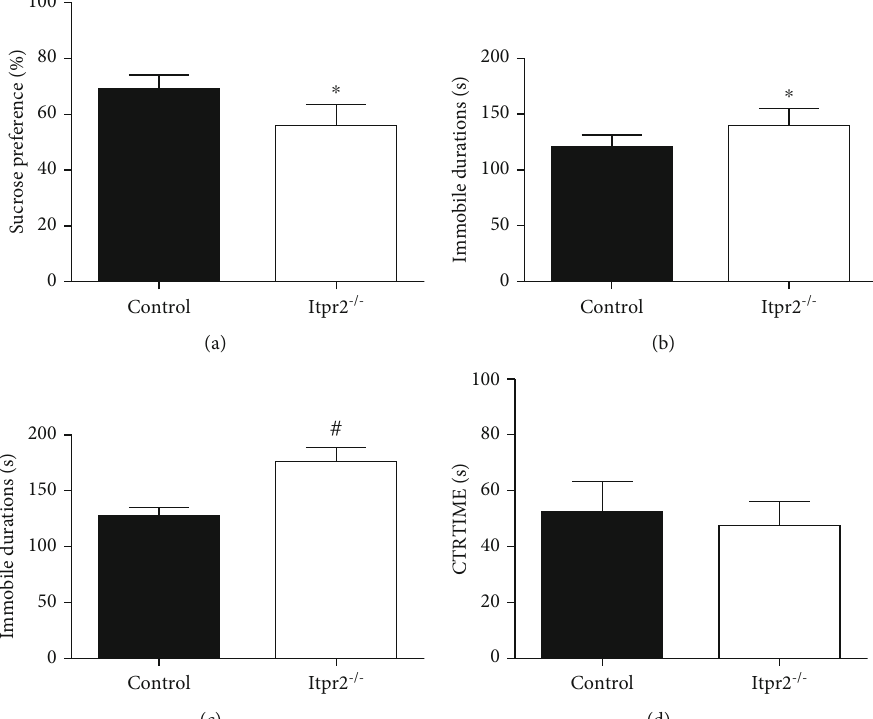
Figure 1: Behavior test of Itpr2 -/- mice and controls. (a) Sucrose preference. (b) Tail suspension test immobile time. (c) Forced swim test immobile time. (d) Open- fi eld test center time. Data are expressed as the mean ± SD . Asterisk indicates P < 0 : 05 and number sign indicates P < 0 : 01 when compared with the di ff erence was not statistically signi fi cant ( P = 0 : 4602 , t = 0 : 7758 , df = 8 , F = 1 : 643 ) (Figure 1(d)).